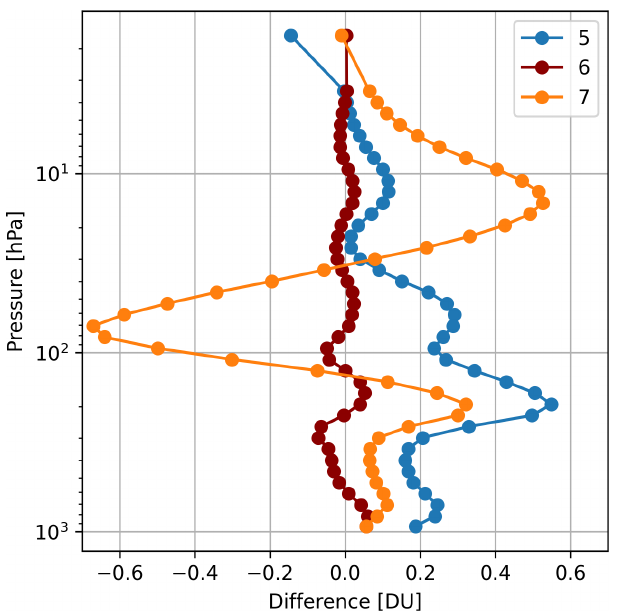
Figure 4. Results of the consistency test applied to the IASI mea- surement for the two formulas CDF (2015) and CDF (2022) com- pared with the retrieval error of the